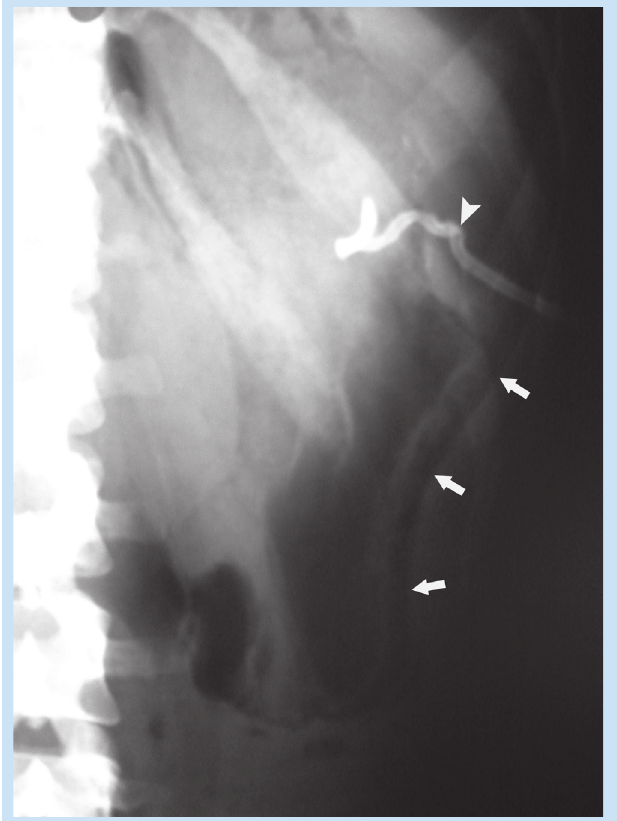
Fig. 1. Plain film demonstrating linear intramural gastric air (arrows) and the left anterior subphrenic percutaneous drain (arrowhead).